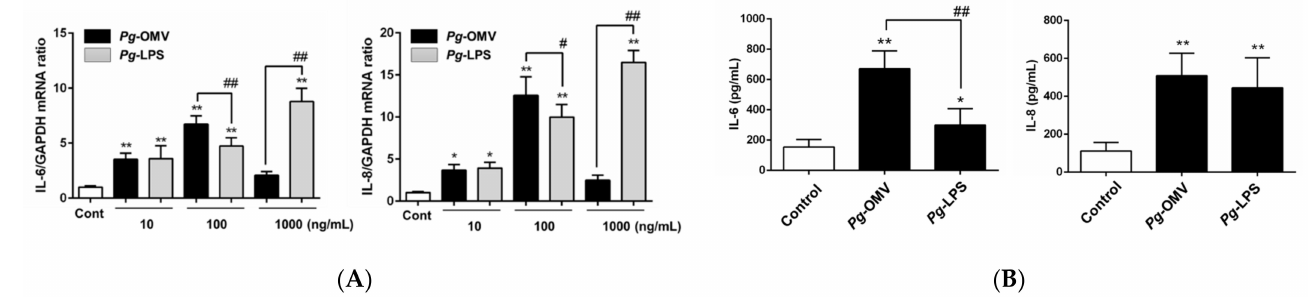
Figure 1. Effect of Pg -OMVs or Pg -LPS on IL-6 and IL-8 mRNA; additionally, protein expression in OBA-9 cells. ( A ) OBA-9 cells were cultured with Pg -OMVs or Pg -LPS (10, 100, or 1000 ng/mL) for 3 h. The amount of Pg -OMVs added to cells was determined by using the same level of endotoxin activity as each concentration of Pg -LPS. IL-6 and IL-8 mRNAs expression levels were analyzed via qRT-PCR. ( B ) OBA-9 cells were cultured with Pg -OMVs or 100 ng/mL of Pg -LPS for 6 h. IL-6 and IL-8 concentrations in the cell culture supernatants were determined using an ELISA program. Data are the mean ± SD of three independent experiments. * p < 0.05 and ** p < 0.01, compared to the control. # p < 0.05 and ## p < 0.01, compared to Pg -OMVs.